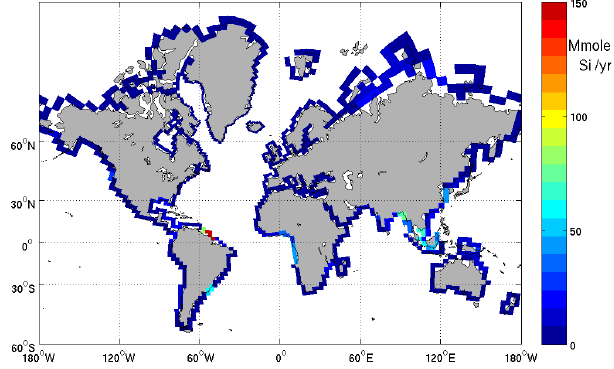
Fig. 1. Integrated annual flux of silica as added in the model grid, according to the 129 coastal segments from the COSCAT approach. Riverine silica inputs are given in megamoles Si per